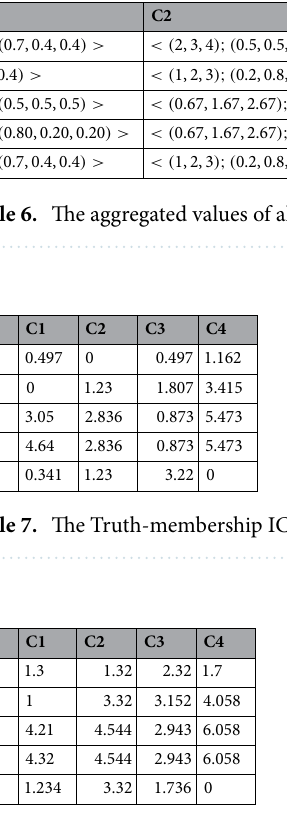
Table 8. The Indeterminacy-membership IC.